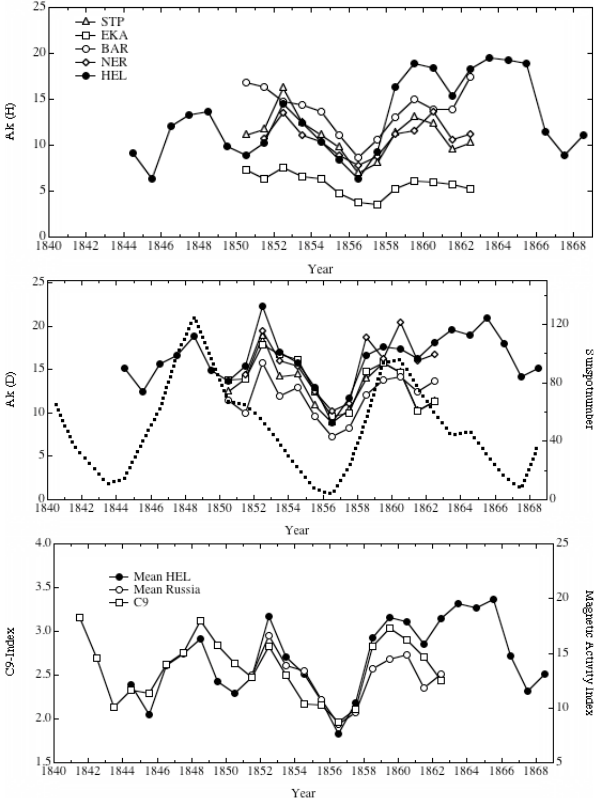
Fig. 6. Upper panel: Annual means of daily magnetic activity in- dex (Ak) from Russian observatories and Helsinki (HEL) as cal- culated from the D-component. Mid-panel: Activity indices as calculated from the H-component. Dotted line: Annual means of sunspot numbers. Lower panel: Mean values of activity indices based on H- and D-data for Helsinki (HEL) (dots), the Russian sta- tions (Mean Russia) (circles) and the C 9-activity index calculated from STP